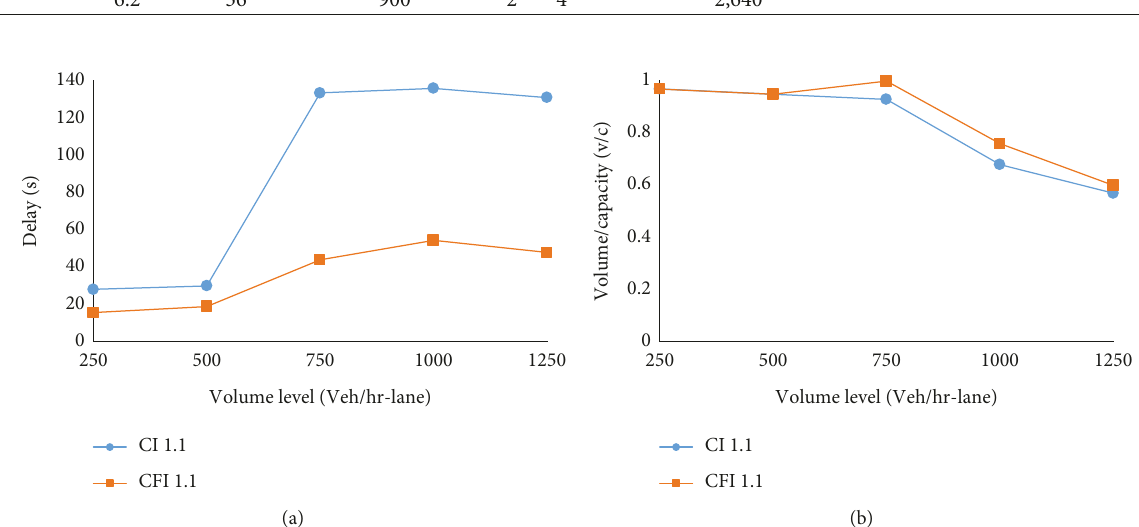
Figure 4: Delay and capacity for the CI versus CFI, group 1: (a) left-turn delay and (b) left-turn